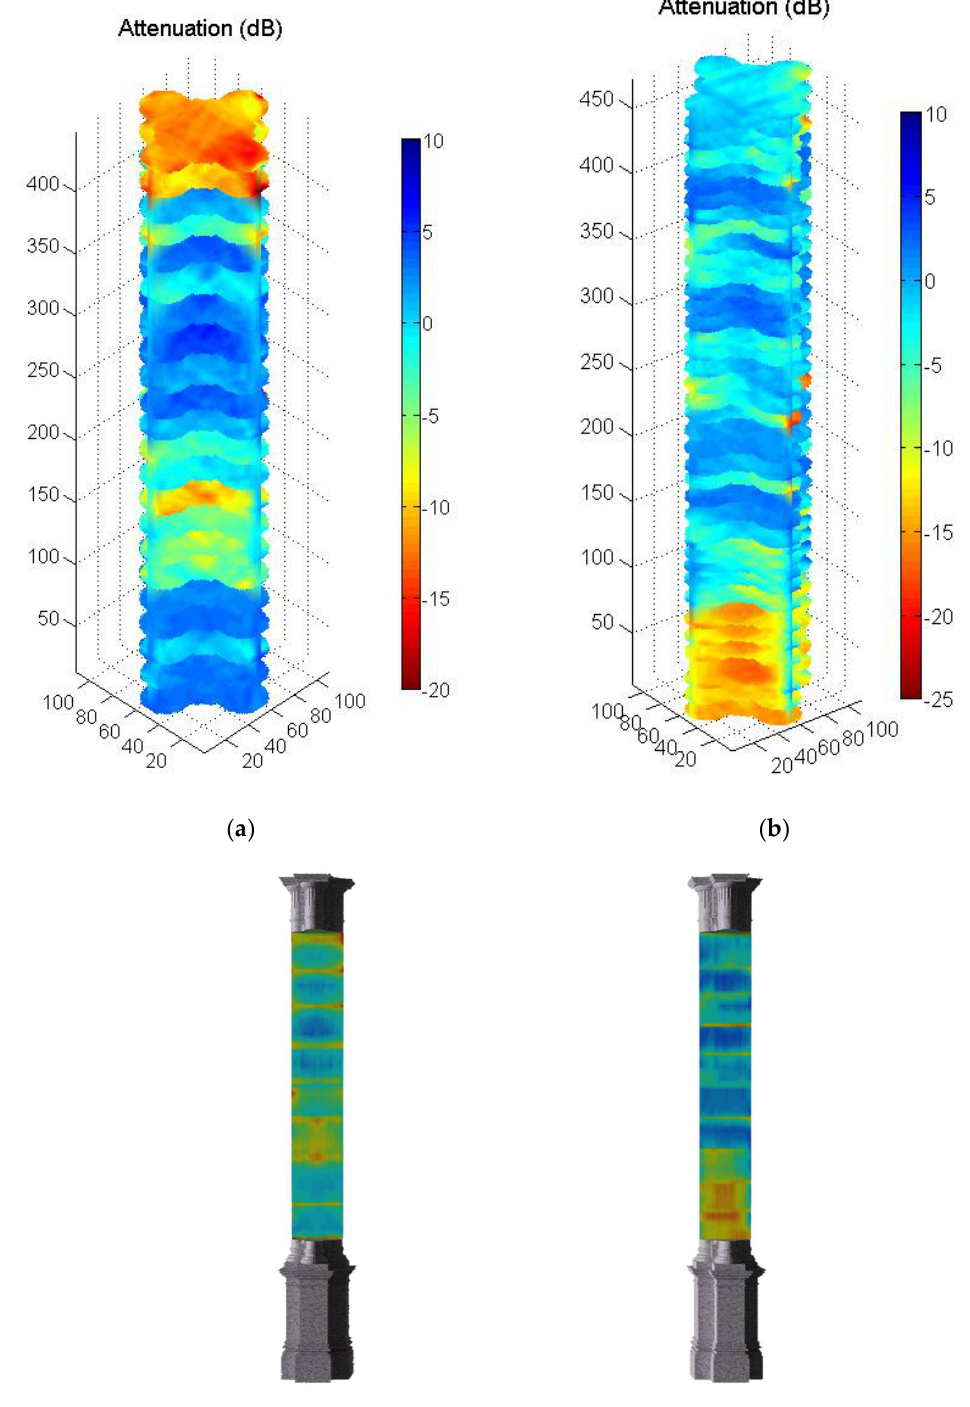
Figure 24. ( a ) Tomographic images (3D) of drums from: column 2, ( b ) column 3, ( c ) integration of tomographic images in a geometrical